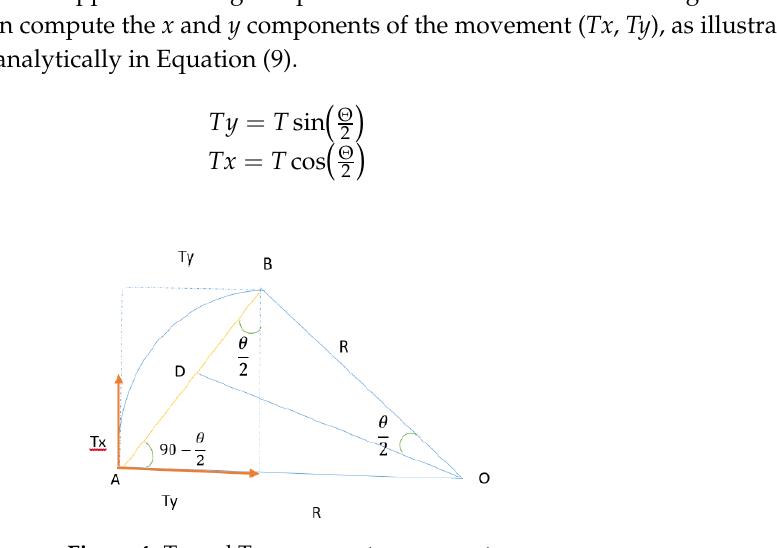
Figure 4. Tx and Ty movement components.